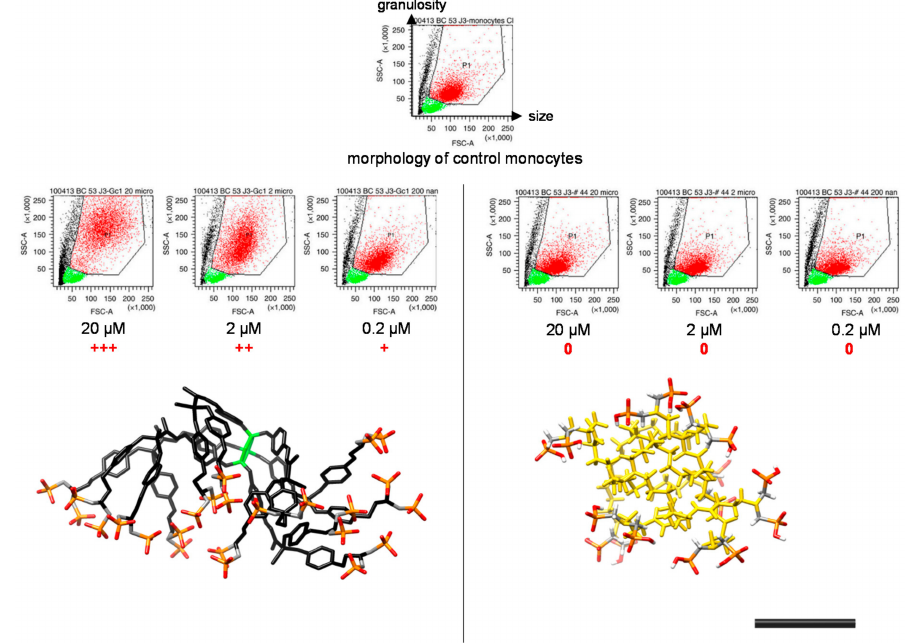
Figure 5. Relation between the bioactivity and the 3D structure of dendrimers. The bioactivity of dendrimers on human monocytes was analyzed by flow cytometry. Each dot in the plots is indicative of morphological changes (size—the Forward SCatter (FSC) parameter on the x axis—and granulosity—the Side SCatter (SSC) parameter on the y axis) undergone by purified human monocytes (red points gated in the polygon) in the presence of the dendrimers at 20, 2, and 0.2 µ M. Green points are the remaining lymphocytes after purification, black points are dead or dying cells. Under the dot plots, the 3D conformation of dendrimers in water solution. +++ indicates strong morphological changes (increase in size and granulosity) when compared to control monocytes, ++ indicates mild changes, + indicates slight changes, 0 indicates no change. On the left: directional conformation of the bio-active ABP dendrimer which is the paradigm of anti-inflammatory ABP-capped dendrimers; on the right: non-directional conformation of an inactive PAMAM dendrimer on the second-generation capped with eight ABP groups at its surface. The black bar represents 1 nm. The phosphonate groups appear in red (oxygen atoms) and orange (phosphorus atoms) (see [28]). Reproduced with